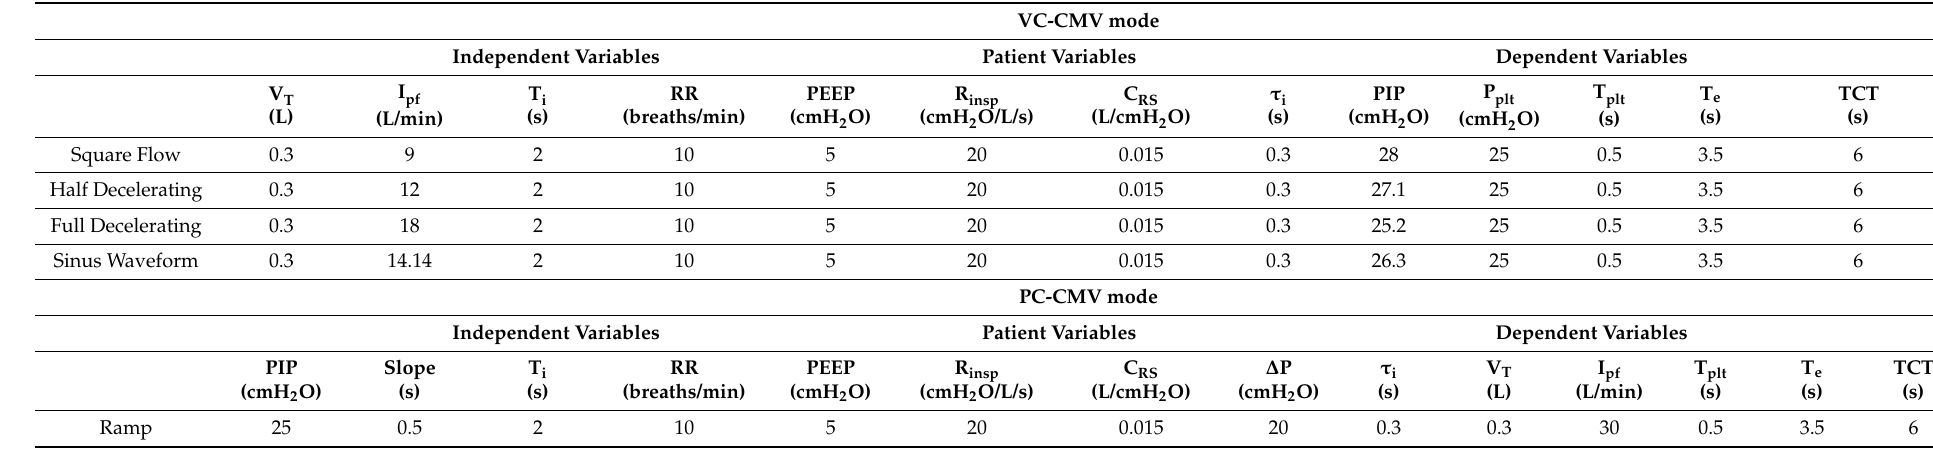
Table 5. Independent, dependent, and patient variables of the real-life trends of the Case 1.